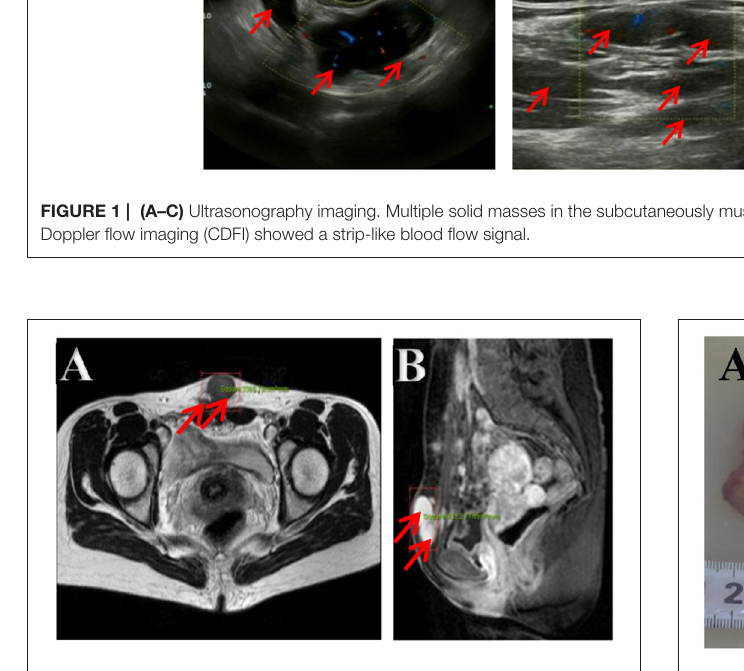
FIGURE 2 | (A,B) Pelvic cavity magnetic resonance imaging. Multiple nodes in the abdominal wall, in the right iliac fossa, and behind the uterus, with lower T1- and T2-weighted image. The bigger showed homogeneous enhancement on enhancement images in the soft tissue of the lower abdominal wall.